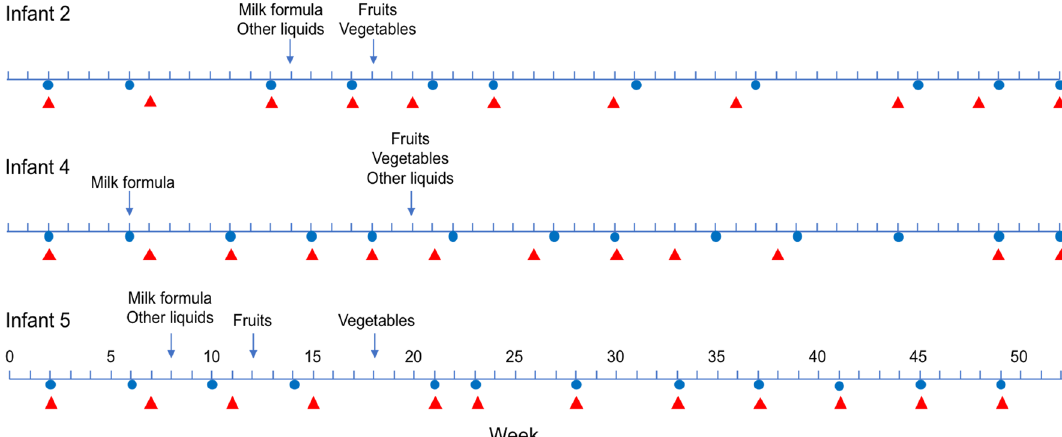
Figure 1. Overview of fecal and oropharynx sample collection from the three children enrolled in the study. Blue circles, feces collection; red triangle, oropharynx swab collection. The week when the children started to ingest foods different from breast-milk is